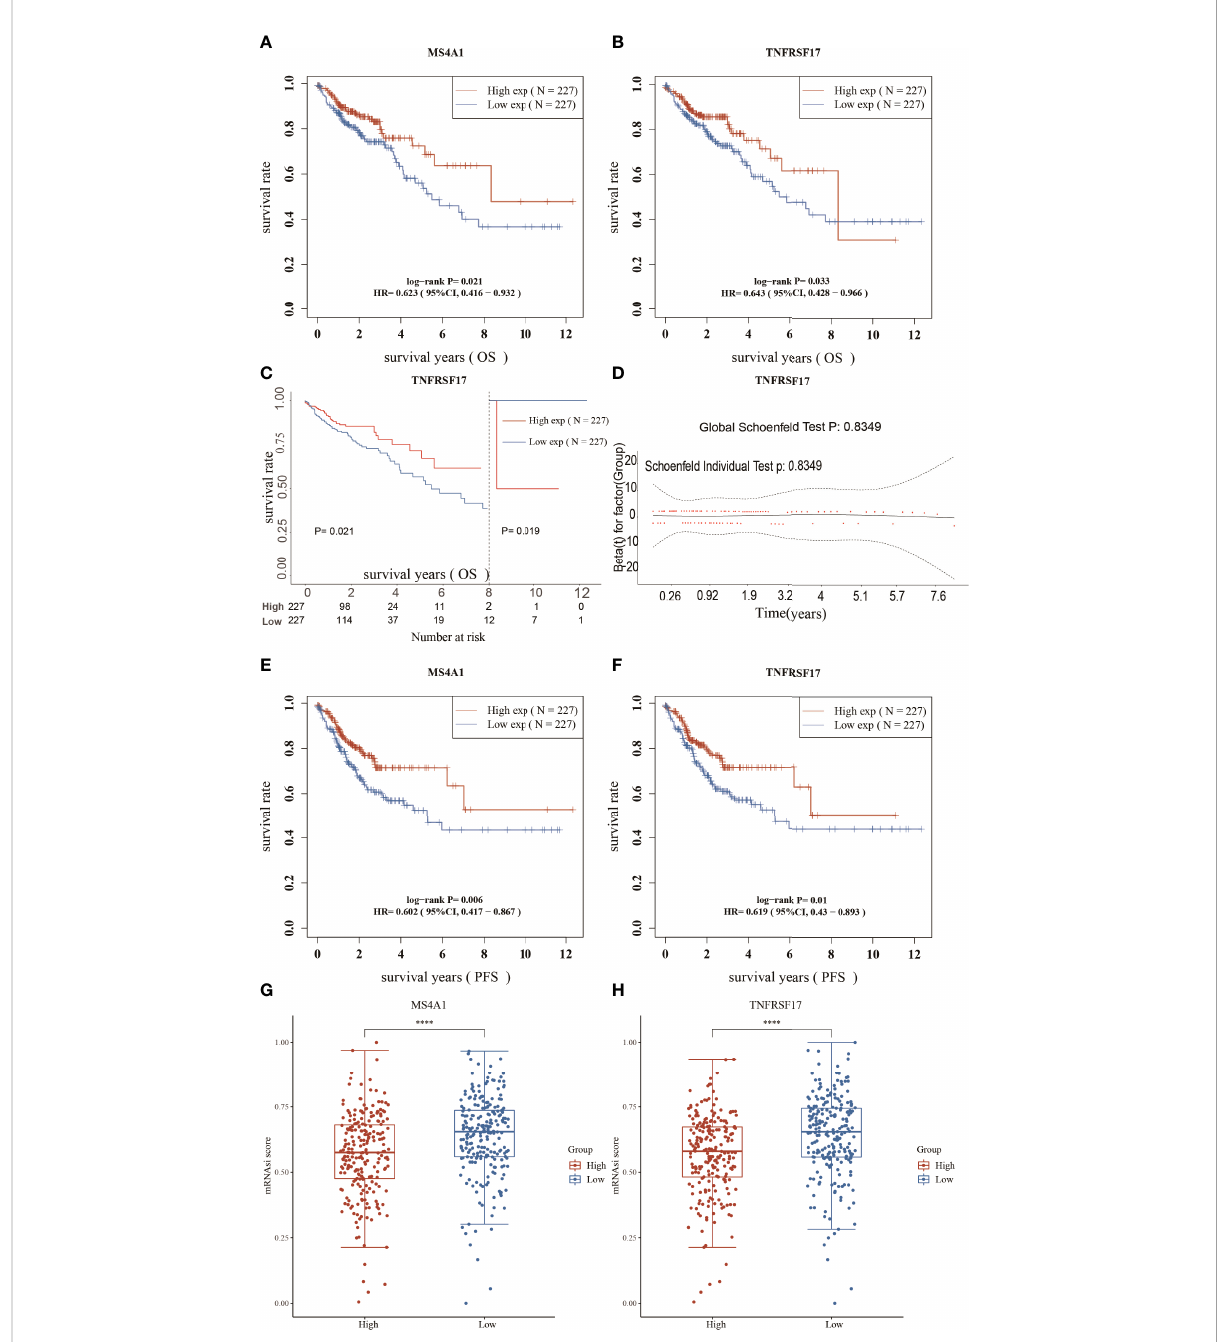
FIGURE 3 Survival analysis and stemness scores. (A) Overall survival (OS) analysis of the high- and low-MS4A1-expression groups. (B) OS analysis of the high- and low-TNFRSF17-expression groups. (C) Landmark analysis results (D) Proportional risk assumption results (E) Progression-free survival (PFS) analysis of the high- and low-MS4A1-expression groups. (F) PFS survival analysis of the high- and low-TNFRSF17-expression groups. (G) Stemness scores of the high- and low-MS4A1-expression groups. (H) Stemness scores of the high- and low-TNFRSF17-expression groups.